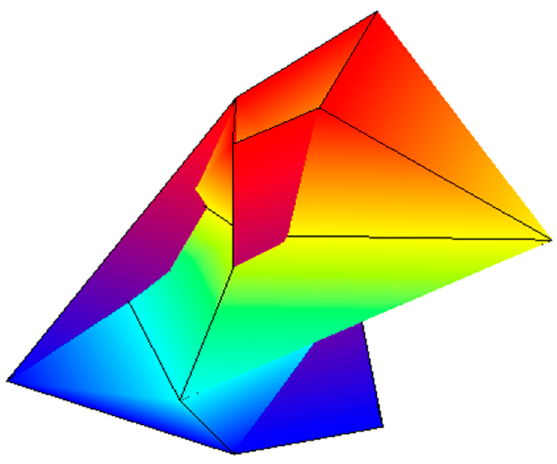
Figure 10. Artistic representation of a multiclass confusion matrix. Table 3. Classification performance metrics.